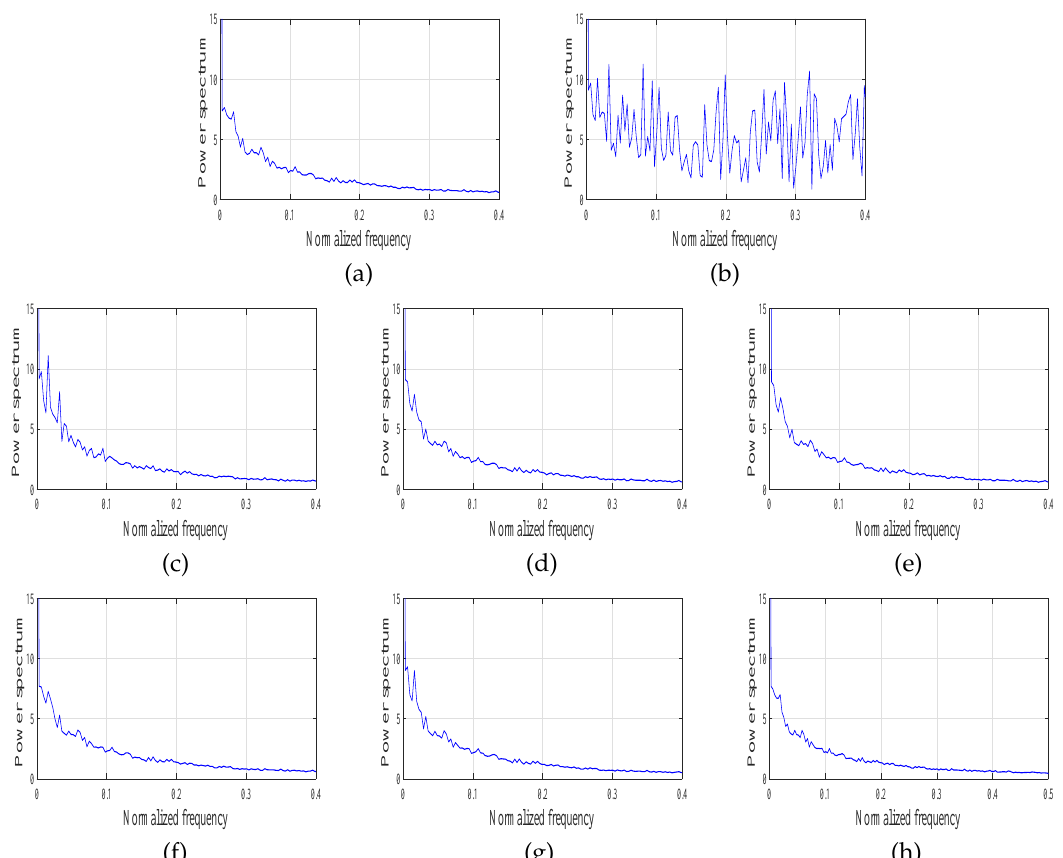
Figure 11. Power spectrum for simulated image of the second example of Figure 7: ( a ) underlying image; ( b ) degraded image; and destriping results by: ( c ) WFAF; ( d ) SLD; ( e ) UTV; ( f ) GSLV; ( g ) LRSID; and ( h )